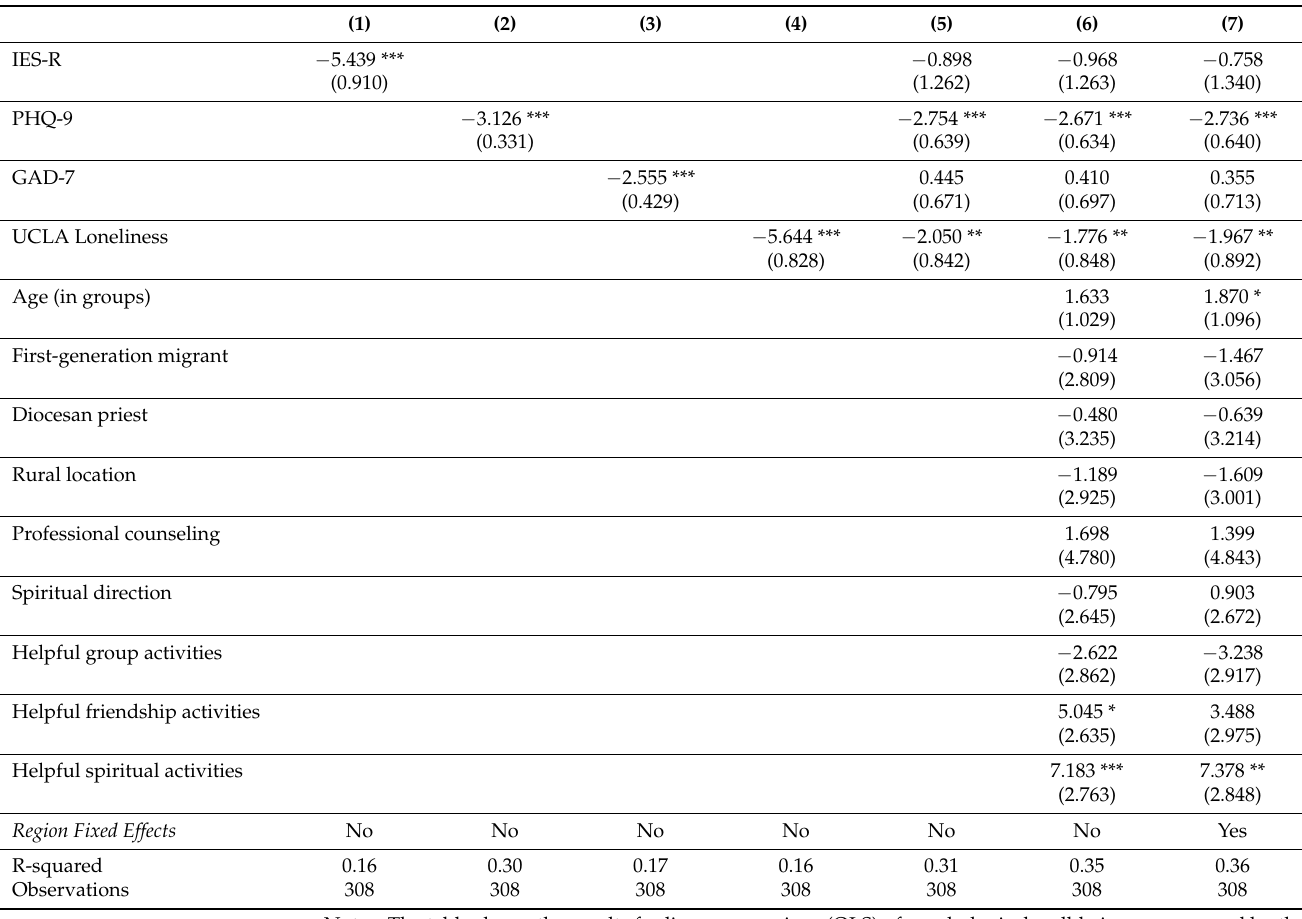
Table 2. Aspects of COVID-19 distress and psychological